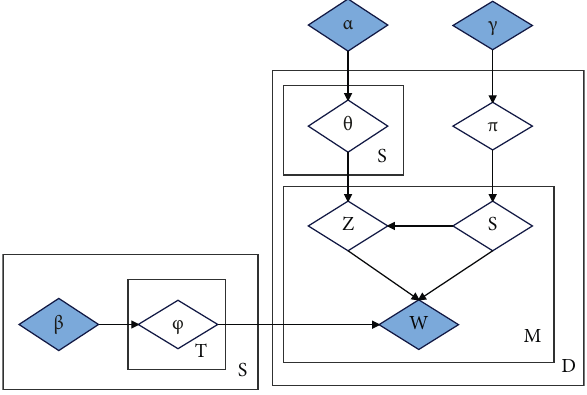
Figure 3: ASUM graphical